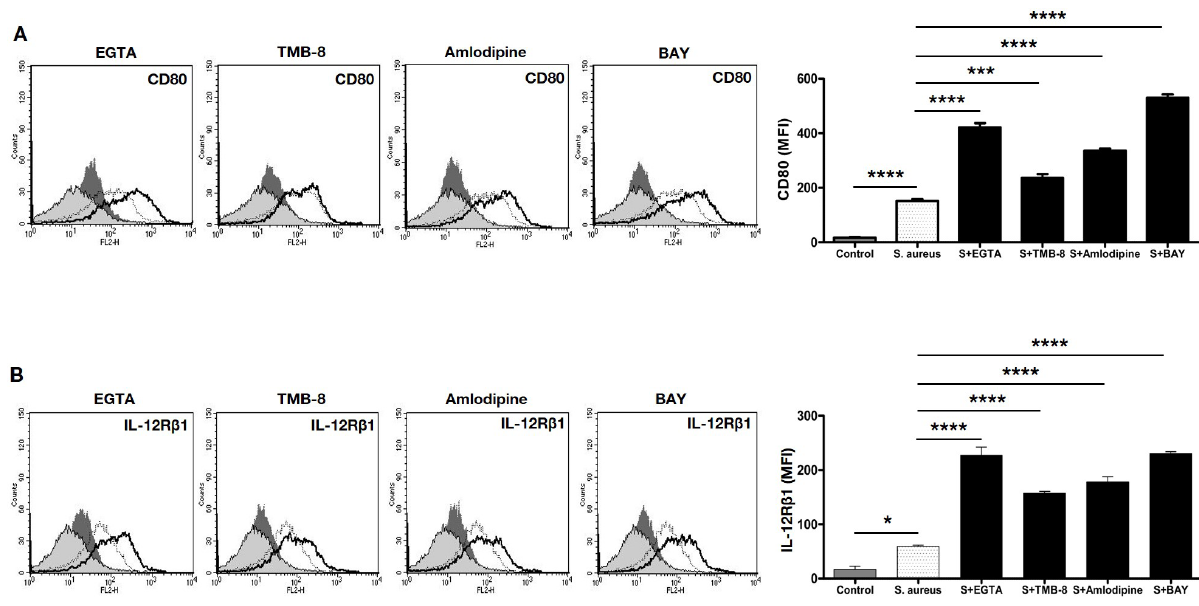
Figure 1: Calcium differentially regulates expression of T cell co-stimulatory molecules on macrophages during S. aureus infection. Murine J774 macrophages were incubated with either EGTA or TMB-8 or BAYK8664 or amlodipine for 2h followed by infection with 20 MOI S. aureus infection for 24h. Cells were stained with anti-CD80-PE (Panel A) or anti-IL-12Rβ1-PE (Panel B) and analyzed by flow cytometry. Shaded histograms represent unstimulated control, dark shaded represents treatments with calcium modulators only, thin line represents infection with S. aureus and the thick line represents treatment with indicated calcium modulator followed by infection with S. aureus . Data from one of three independent experiments are shown. Bar graphs adjacent to the histograms show Mean Fluorescent Intensity (MFI) of individual groups. Controls represent unstimulated cells. Data represent the mean ± SD of three independent experiments. S indicates S. aureus infection. For Panel A (CD80), P-value between Control and S. aureus is p<0.0001; S. aureus vs S. aureus + EGTA is p <0.0001; S. aureus vs S. aureus + TMB 8 is p=0.006; S. aureus vs S. aureus + Amlodipine is p<0.0001; S. aureus vs S. aureus + BAY is p<0.0001. For Panel B (IL-12Rβ1), P-value between Control vs S. aureus is p=0.0129; S. aureus vs S. aureus + EGTA is p<0.0001; S. aureus vs S. aureus + TMB8 is p<0.0001; S. aureus vs S. aureus + Amlodipine is p<0.0001 and S. aureus vs S. aureus + BAYK8664 is